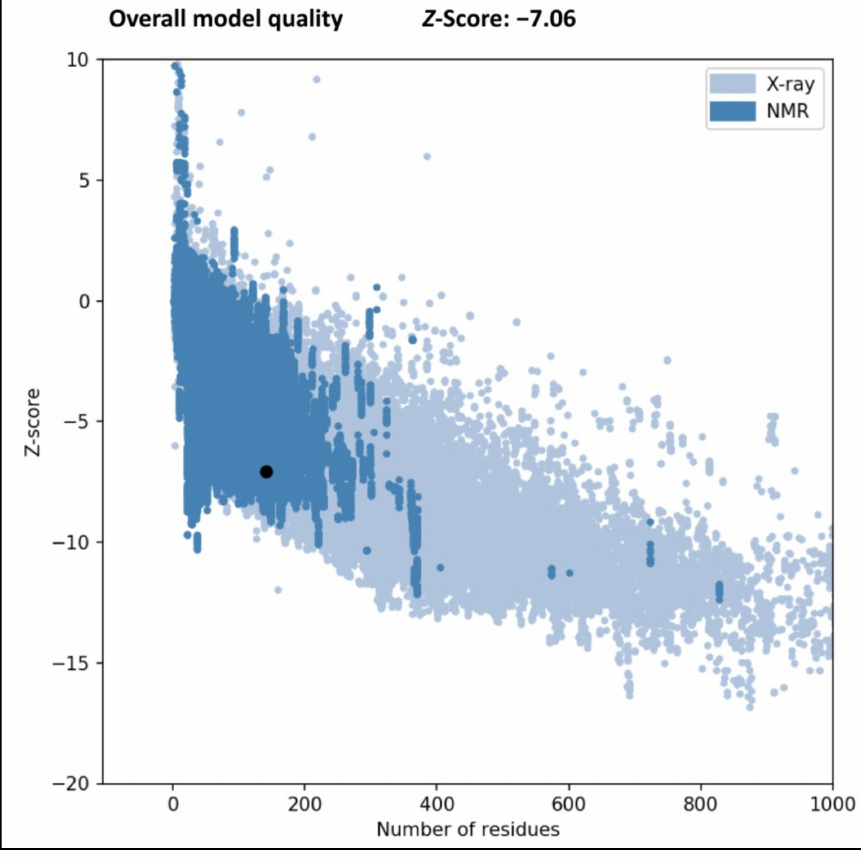
Figure 2. Z-score for the Bcl-2 protein (PDB: 2W3L) structure generated by ProSA web